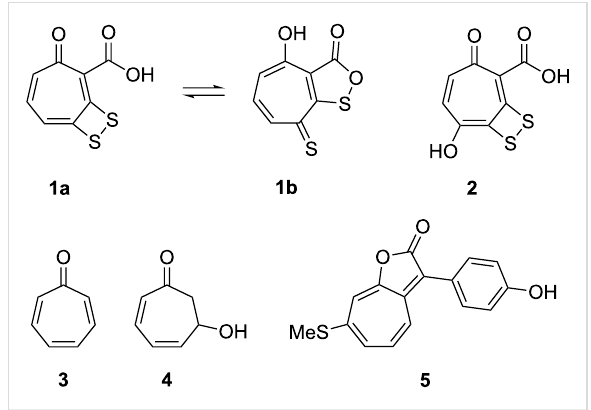
Figure 1: TDA and related natural products from Phaeobacter inhibens